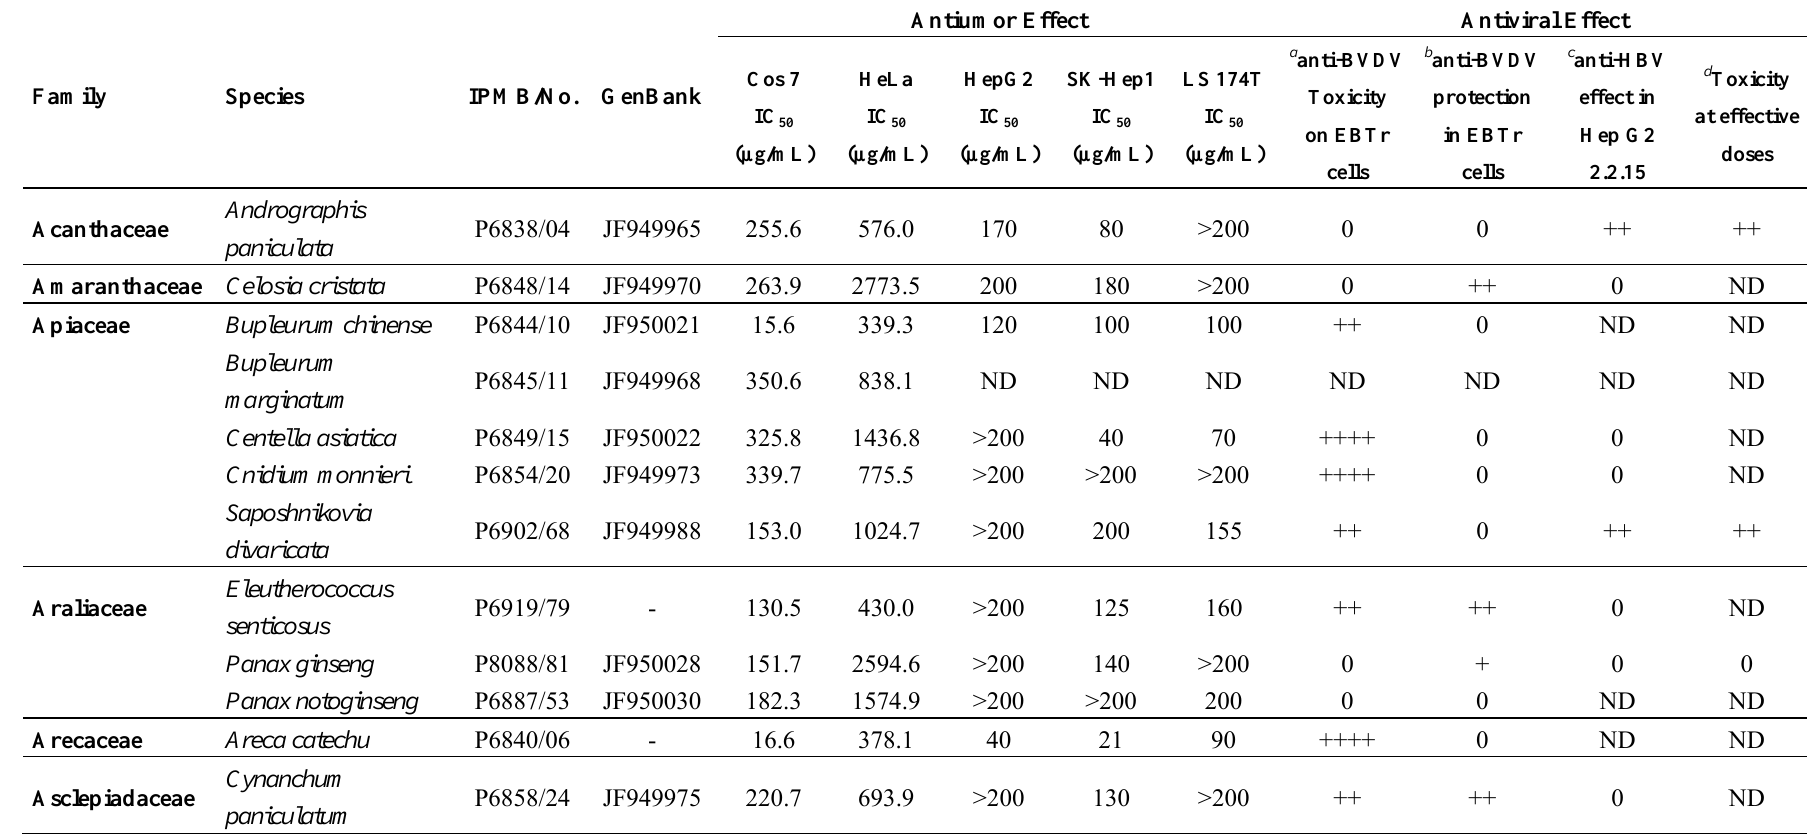
Table 3. Cytotoxicity against cancer cells, Cos7 fibroblasts, and antiviral activity against HBV and flaviviruses of water extracts obtained from 82 medicinal